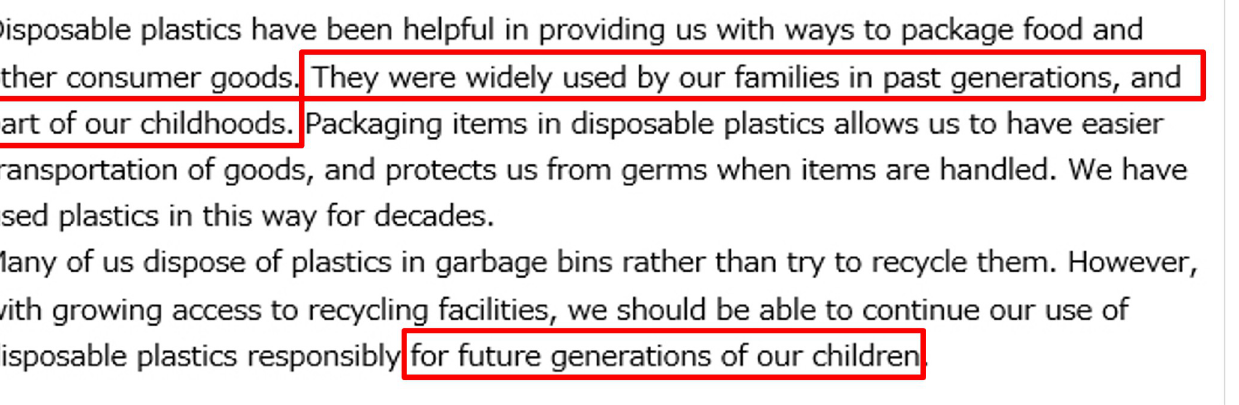
Fig 4. Message presented to treatment group 1. The intervention is highlighted with red rectangles.